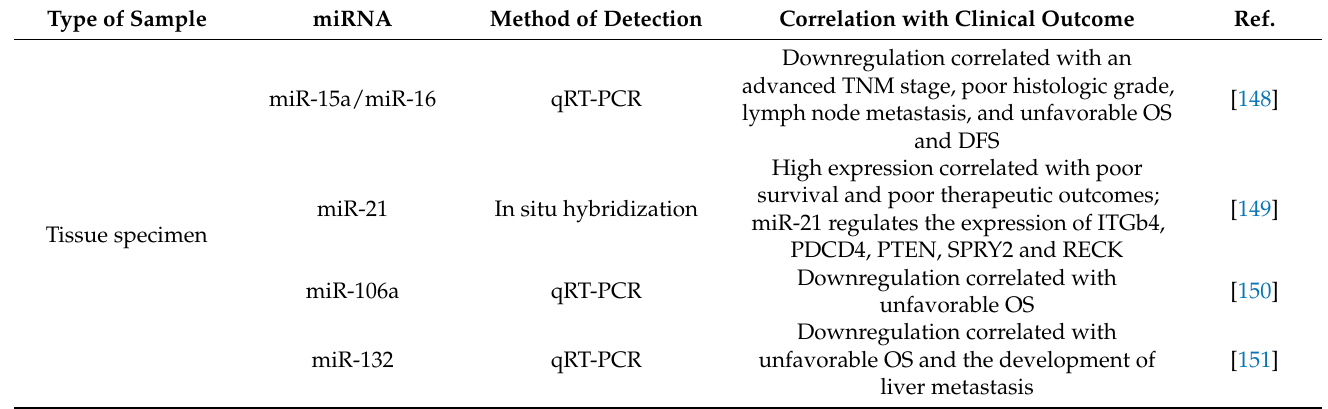
Table 1. miRNAs from tissue specimens, from free circulating/exosome cargo in the serum/plasma and from fecal samples suggested to have prognostic value in patients with metastatic colorectal cancer. Type of Sample miRNA Correlation with Clinical Outcome Ref.